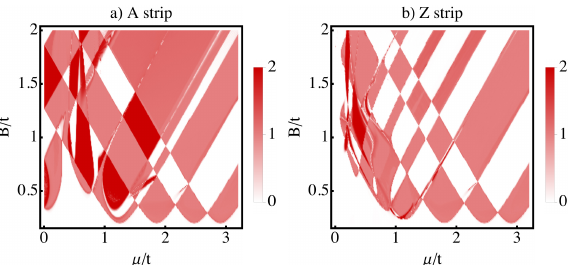
Figure 3: The total MP as a function of the chemical potential and magnetic field for A strips (left panel) and Z strips (right panel). We consider a ribbon of width of W = 5 a and length L = 520 a , for α = 0.5 t and ∆ = 0.2 t .